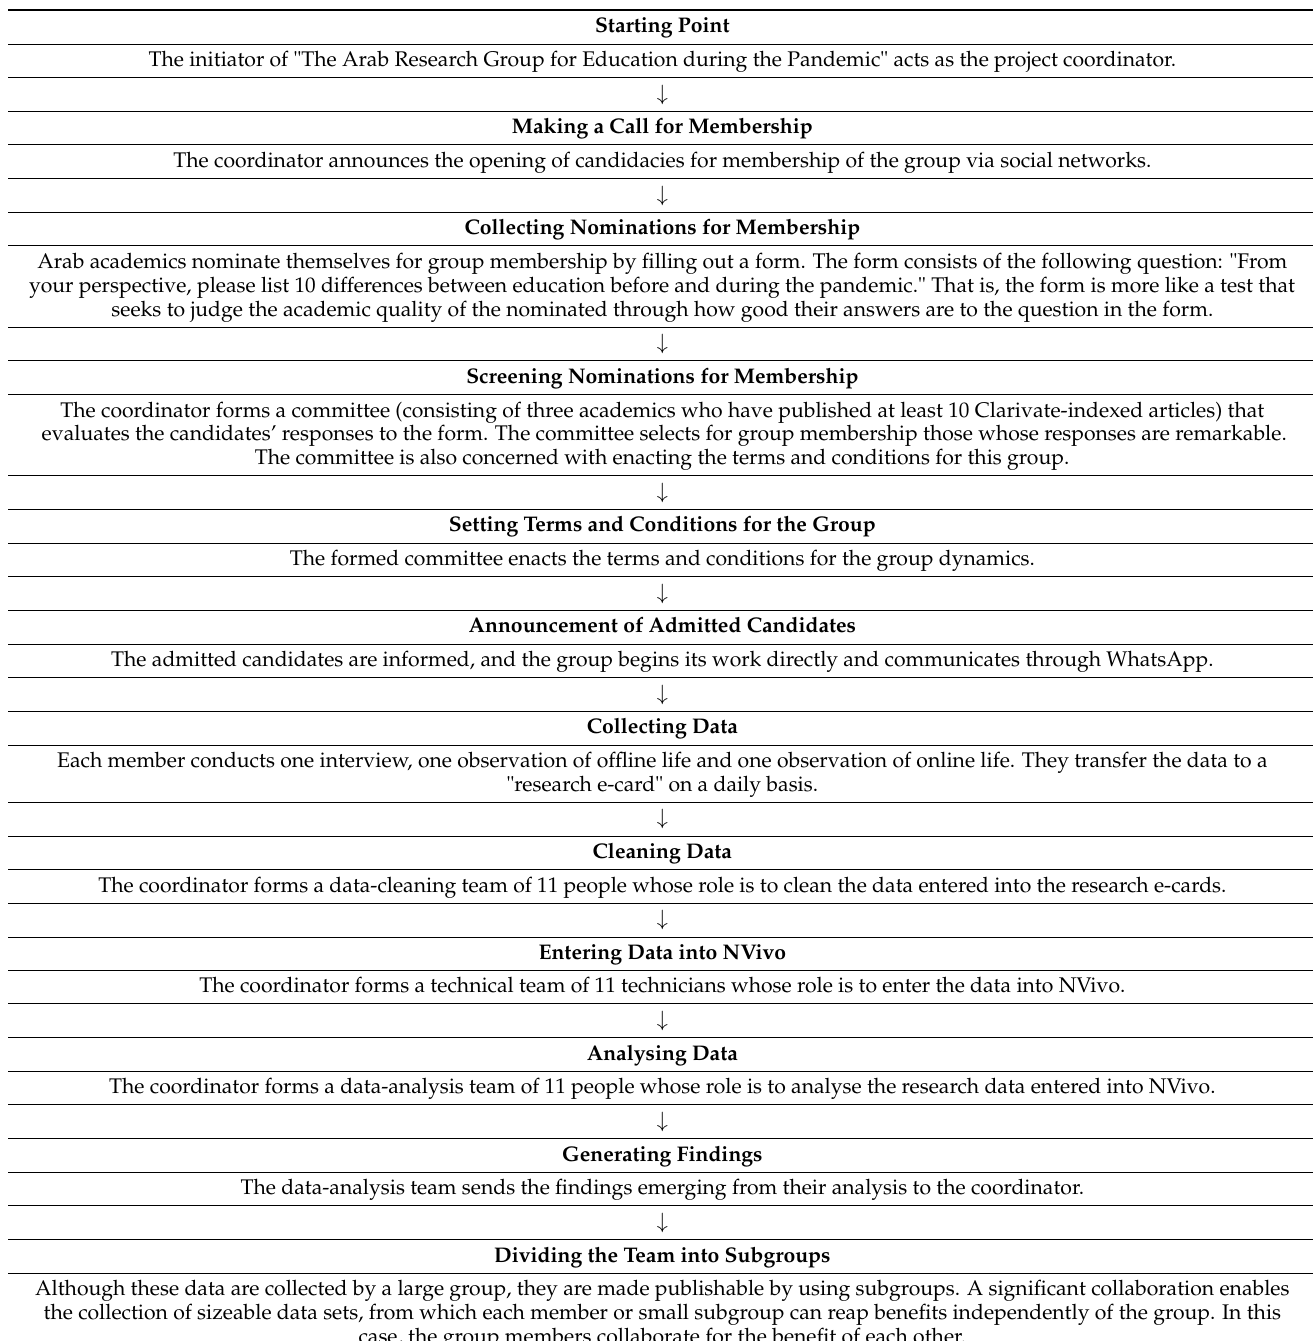
Table 1. Authoring Group Formation and Data